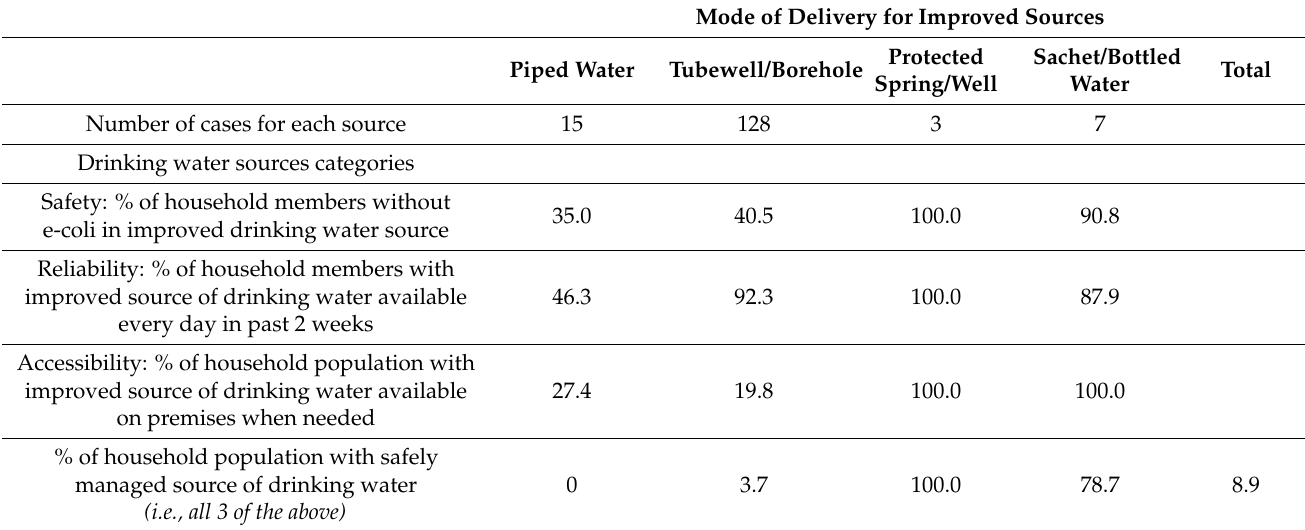
Table 5. Summary of Multiple Indicator Cluster Survey (MICS) 2016–2017 data for Lagos